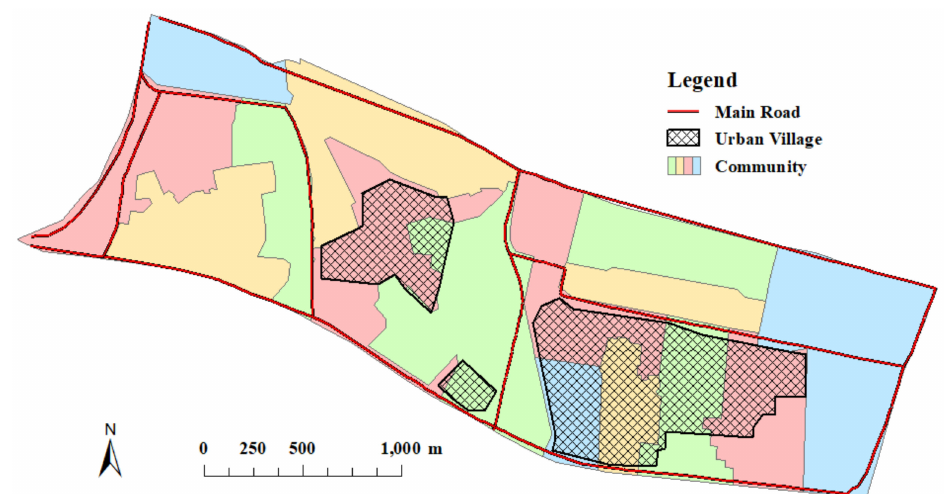
Figure 2. Distribution map of communities, villages, and roads in XT JieDao.